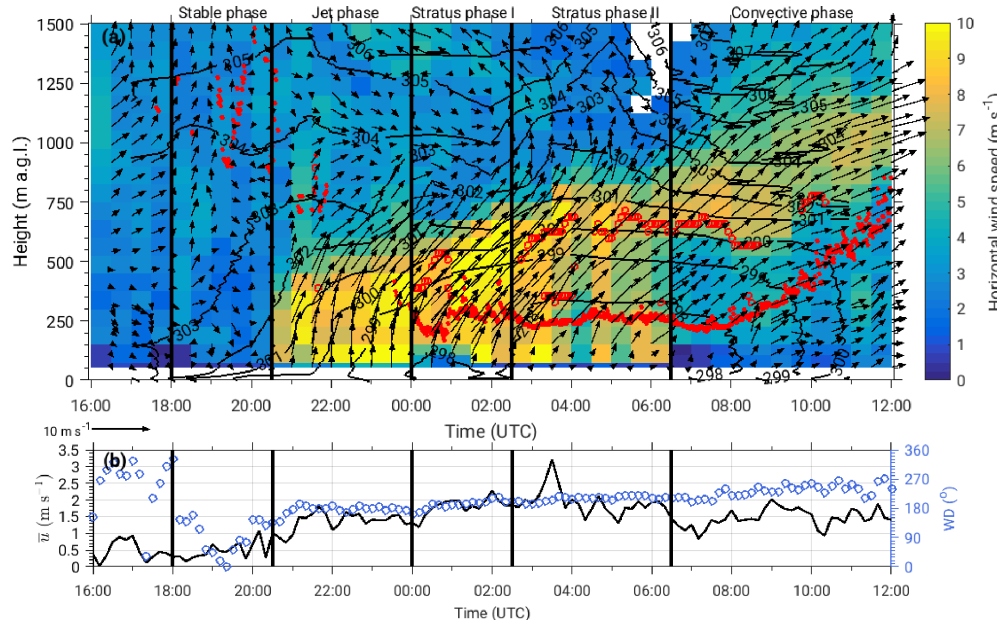
Figure 4. (a) Temporal evolution of the wind speed is shown in color, while arrows show wind direction obtained from sodar and UHF. Black contours show linearly interpolated potential temperature measured every 1.5h by radiosondes. The red dots show CBH and CTH as shown with open red circles. (b) Time series of the near-surface 10min averaged wind speed (black) and wind direction (blue) measured by energy balance station. The vertical black lines indicate the beginning of five different phases observed during this